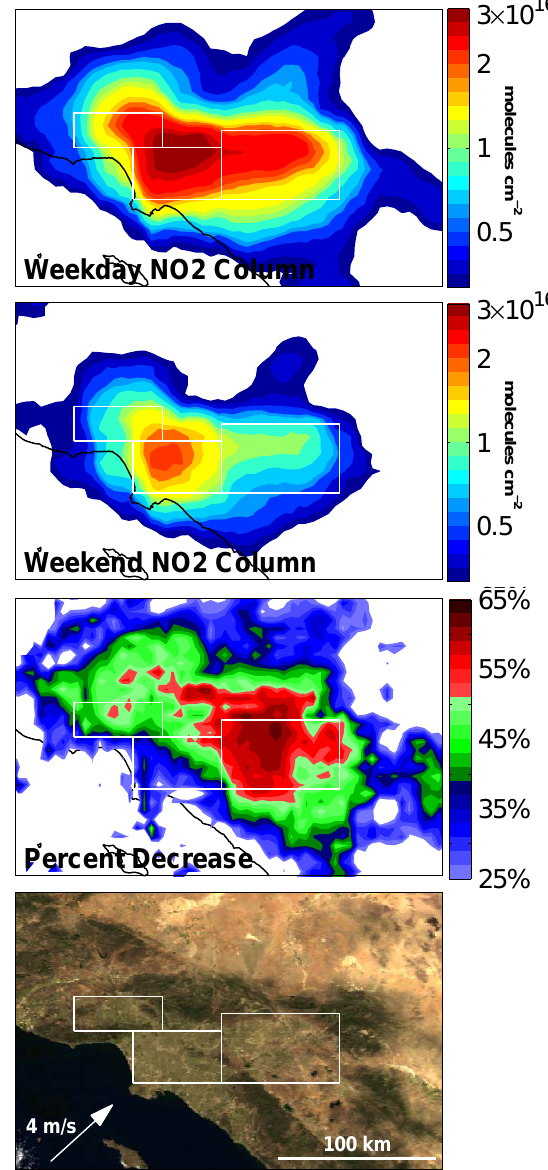
Fig. 2. May–July, 2005–2007 average BEHR NO 2 column (moleculescm − 2 ) for weekdays (top panel) and weekends (second panel), and the percent weekend decrease (third panel). MODIS RGB image of Southern California (fourth panel) with the average North American Regional Reanalysis winds for the region (33.7 ◦ – 34.0 ◦ N; 117.7 ◦ –118.4 ◦ W) reported in the bottom-left corner, and rectangles marking the San Fernando (NW), Los Angeles (SW) and San Bernardino (E)